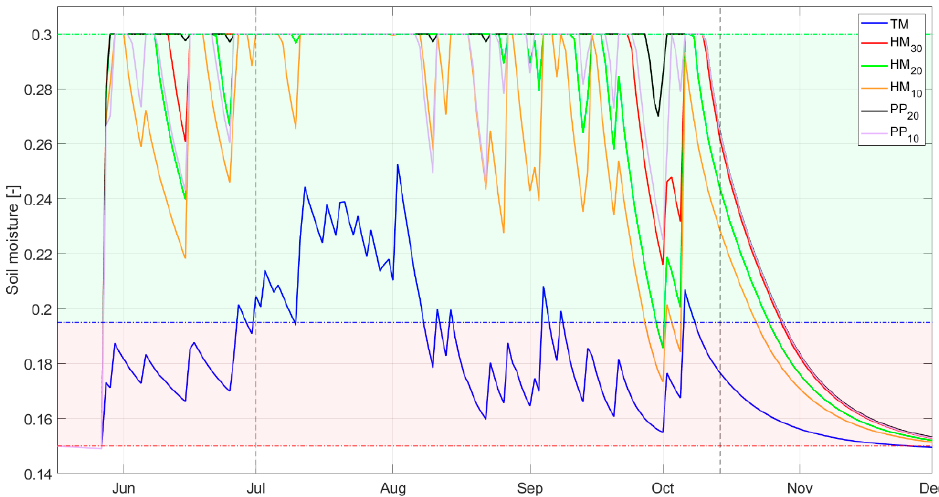
Figure 8. Soil moisture trend at the small scale over the wet season. The red area represents the level of water content lower than the threshold in which the crop is water stressed. The green area highlights the range in which soil water availability is enough to meet the demand of the crop. The boundary between the two areas corresponds to the threshold of readily available water (blue dash-dotted line). The upper and lower limits are the soil moisture at saturation and permanent wilting point, respectively. The vertical dashed lines represent the growing period, from the sowing (left) to the harvest (right).